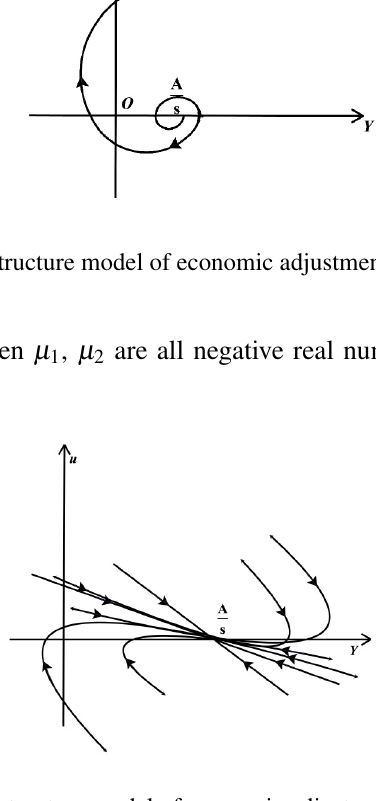
Fig. 7 Differential structure model of economic adjustment under stable nodes